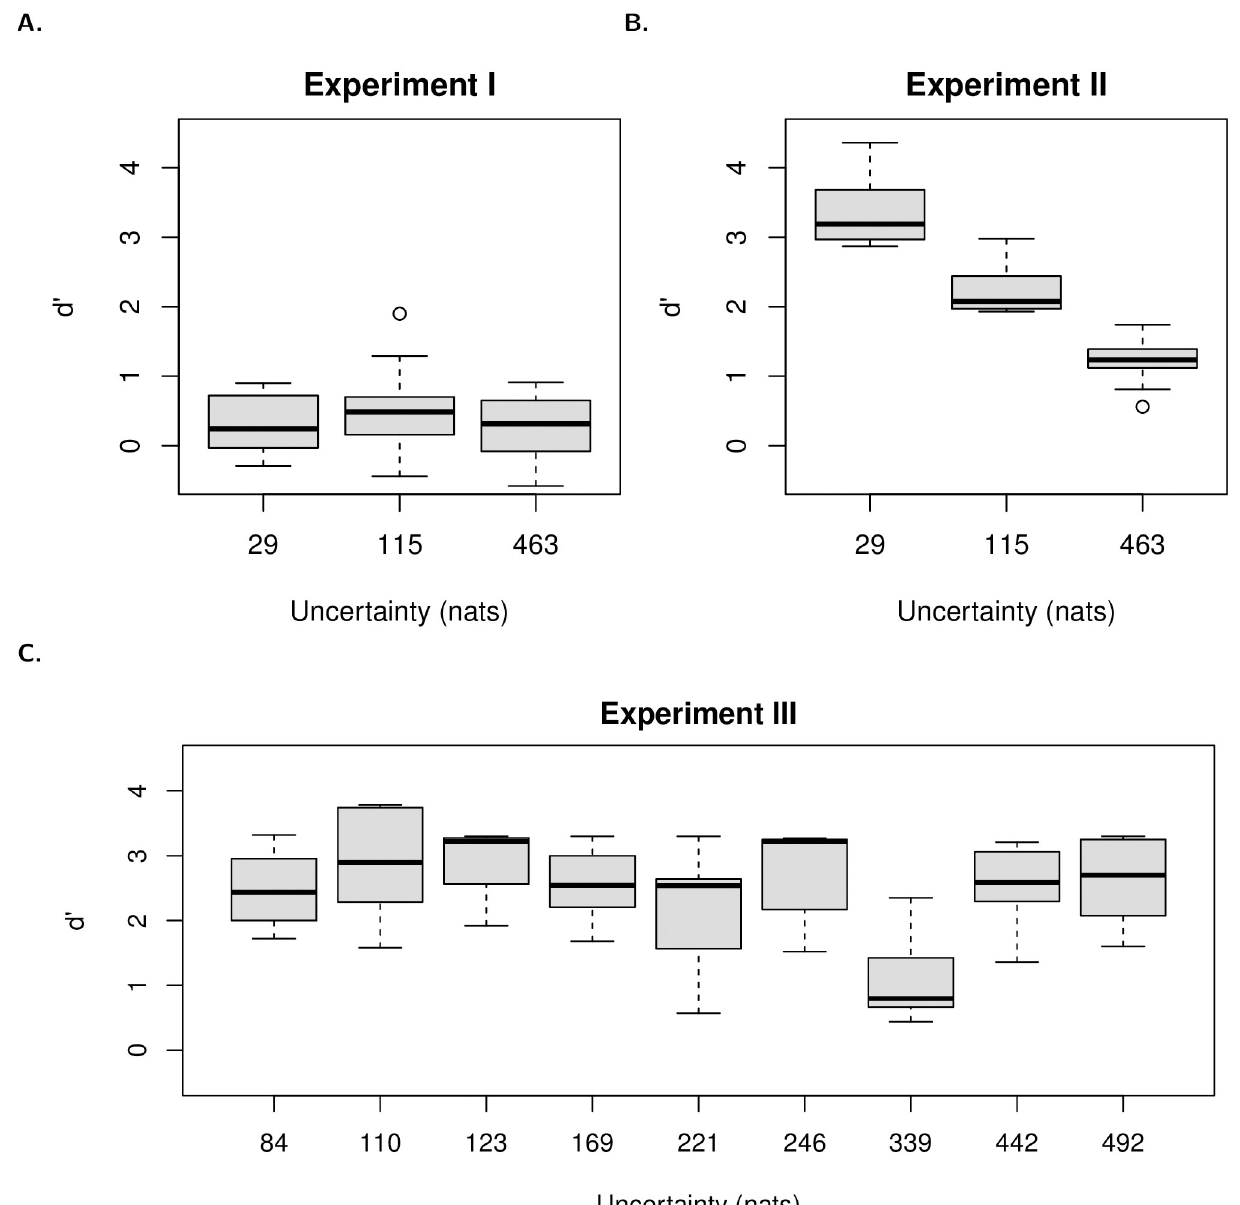
Fig 2. Detection performance index d 0 as a function of masker uncertainty in Experiment I, II and III. Masker uncertainty is measured by entropy in